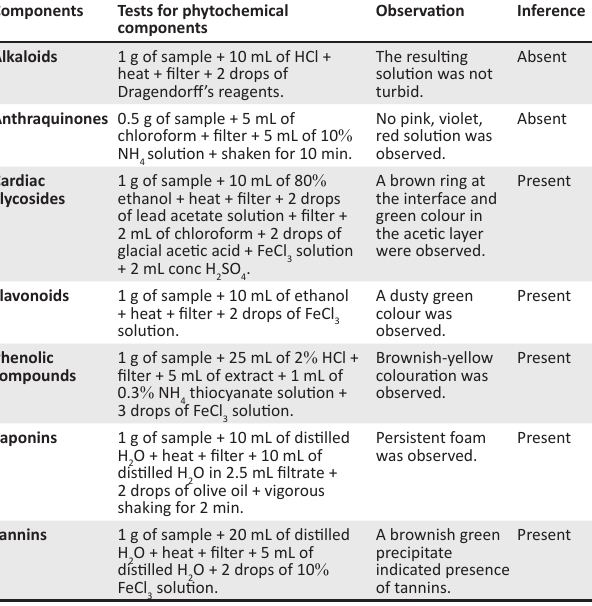
TABLE 2: Qualitative analysis of phytochemical composition of Crescentia cujete leaves on dry basis.